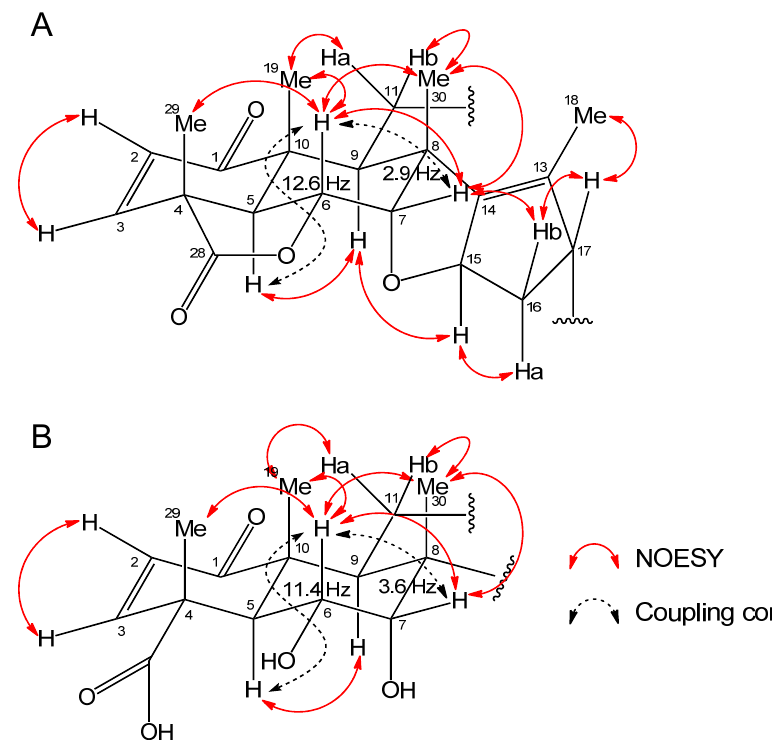
Figure 4. NOESY correlations of compound 1 ( A ) and 2 ( B